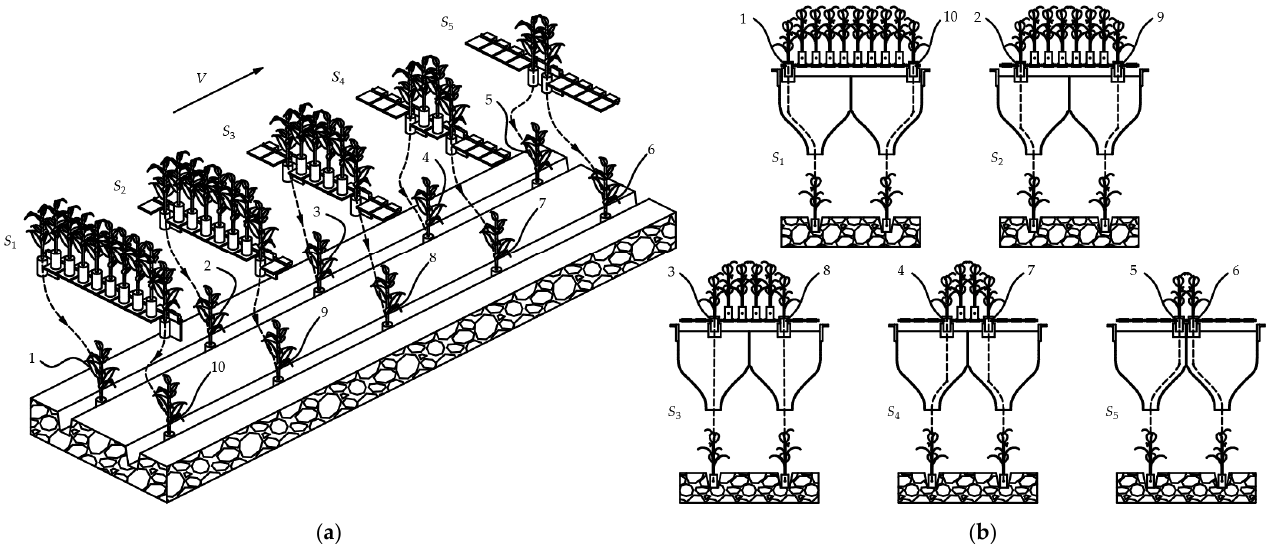
Figure 5. Grouping seedling dropping process and dropping trajectory of pot seedlings at each position: (1)~(10) dropping pot seedlings at different positions, V is the forward speed of transplanting machine, S i is the dropping process of pot seedlings at different positions. ( a ) Dropping order of pot seedlings at each position. ( b ) Dropping trajectory of pot seedlings at each position.